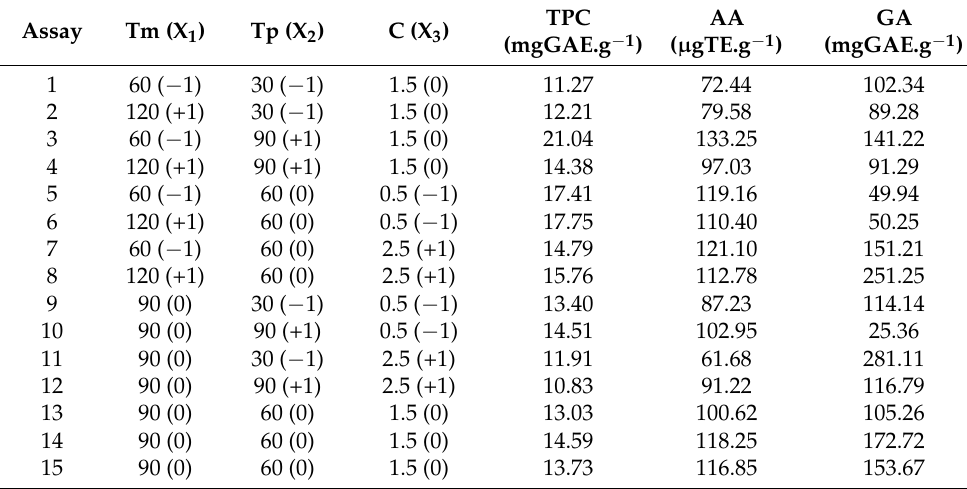
Table 1. PBB experiment matrix and dependent variable responses.